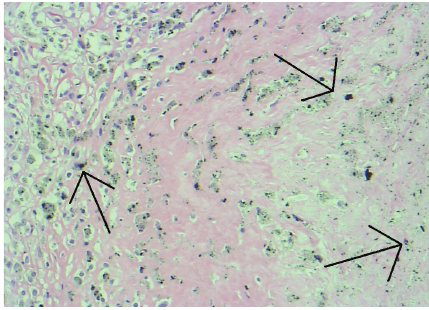
Figure 9: Histiocytes with black (metal) pigment (arrows) diffusely seen throughout tissue